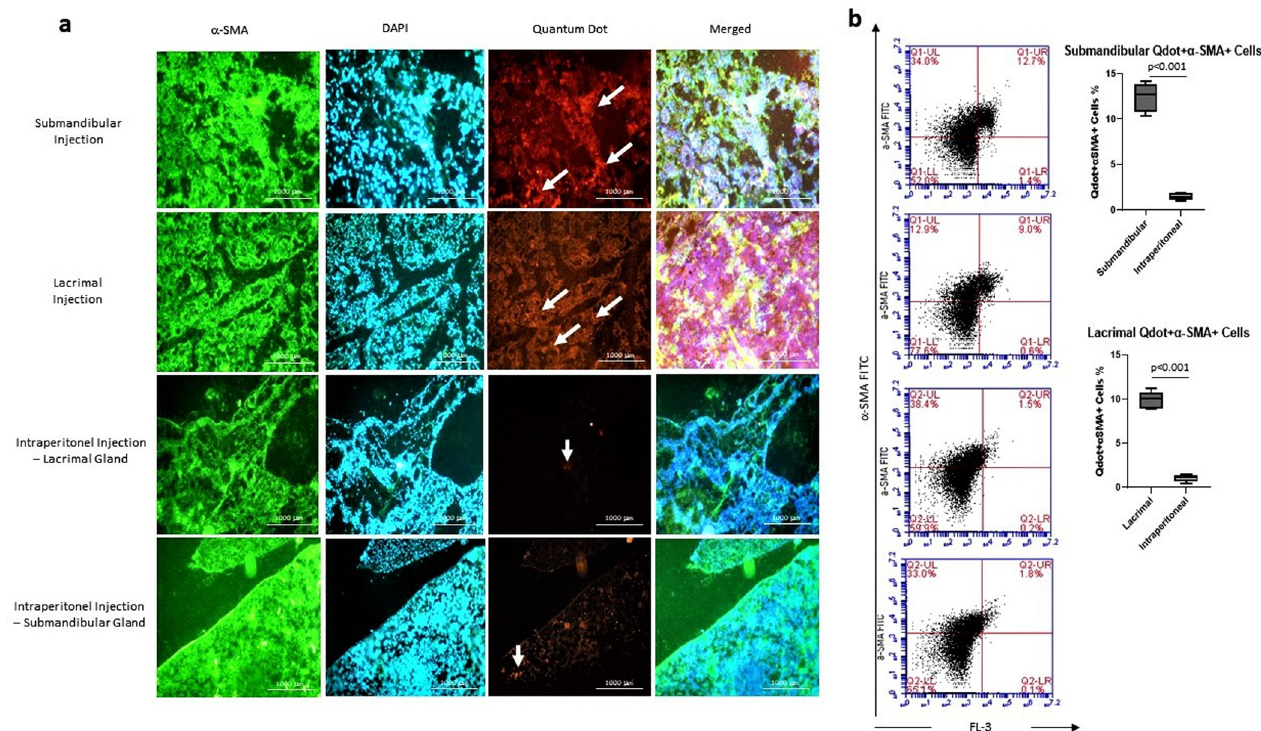
Fig 8. The differentiation analysis of DFMSCs into epithelial lineage in glandular tissues. (a) The fluorescent microscope images of glandular tissues. Glandular tissues were stained with α -SMA (FITC) and DAPI, and analyzed for Quantum dot 655 (Qdot-655) labeled cells. Submandibular and lacrimal injections of DFMSCs showed high differentiation into glandular epithelial cells on day 28 compared to the intraperitoneally injected DFMSCs. (b) Flow cytometry analysis for α -SMA stained cells within Qdot-655 labeled cells. The submandibular and lacrimal injections of DFMSCs highly express α -SMA in submandibular and lacrimal glands of SS mouse model compared to intraperitoneal injections (p < 0.001 and p < 0.001, respectively). lymphocytic foci (Focus score > 1) (number of lymphocytic foci in submandibular glands (mean ± SEM): 4.6 ± 0.5) (number of lymphocytic foci in lacrimal glands (mean ± SEM): 3.4 ± 0.6)